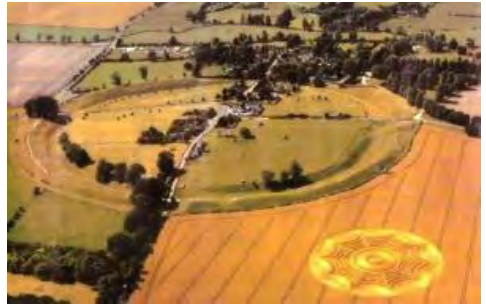
Figure 2 labyrinth stone circle Figure 3 Stone Henges: Earth